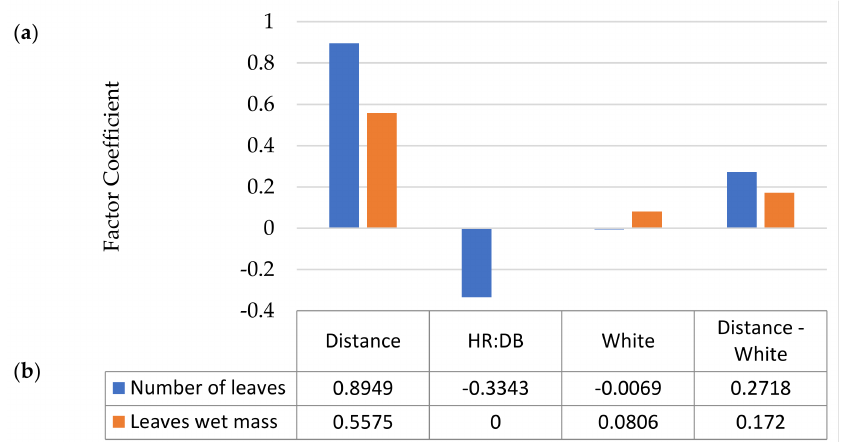
Figure 8. Effects sizes of the most relevant independent variable on several significant responses related to leaf. ( a ) Graphical trend and ( b ) numerical coefficients (error bar = 0.05%, too small to be visible on the graph).